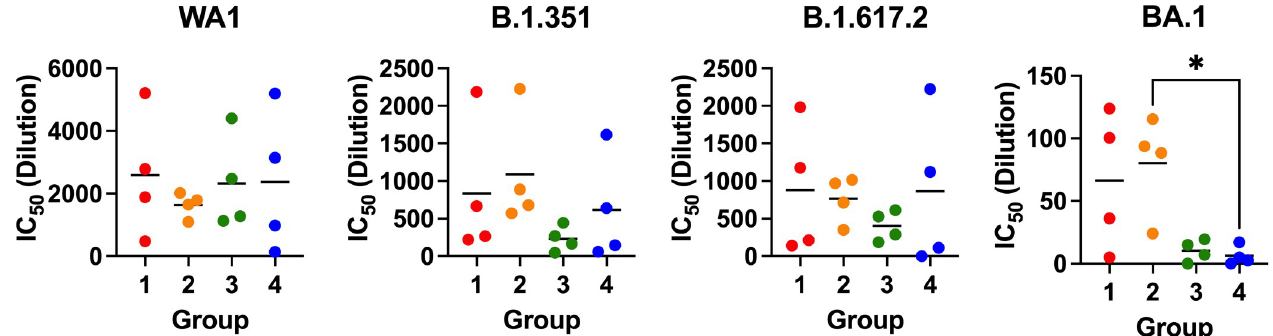
Fig 7. Comparison of IC50s from neutralization of authentic SARS-CoV-2 by immune sera from groups 1–4. IC50s from focus reduction neutralization tests (FRNTs) using the indicated variants of SARS-CoV-2 (Figs 4–6). Each point is 1 mouse. Significance determined by ordinary one-way ANOVA with comparison to reference group 4. � = p < 0.033.